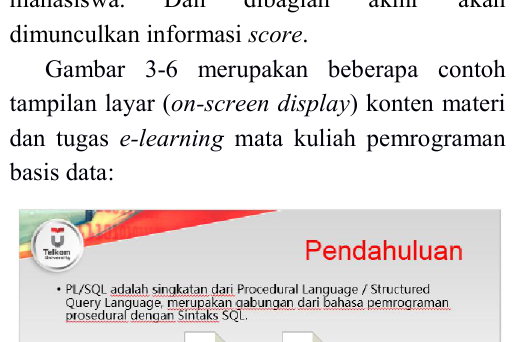
TABEL 3. DAFTAR KONTEN E-LEARNING